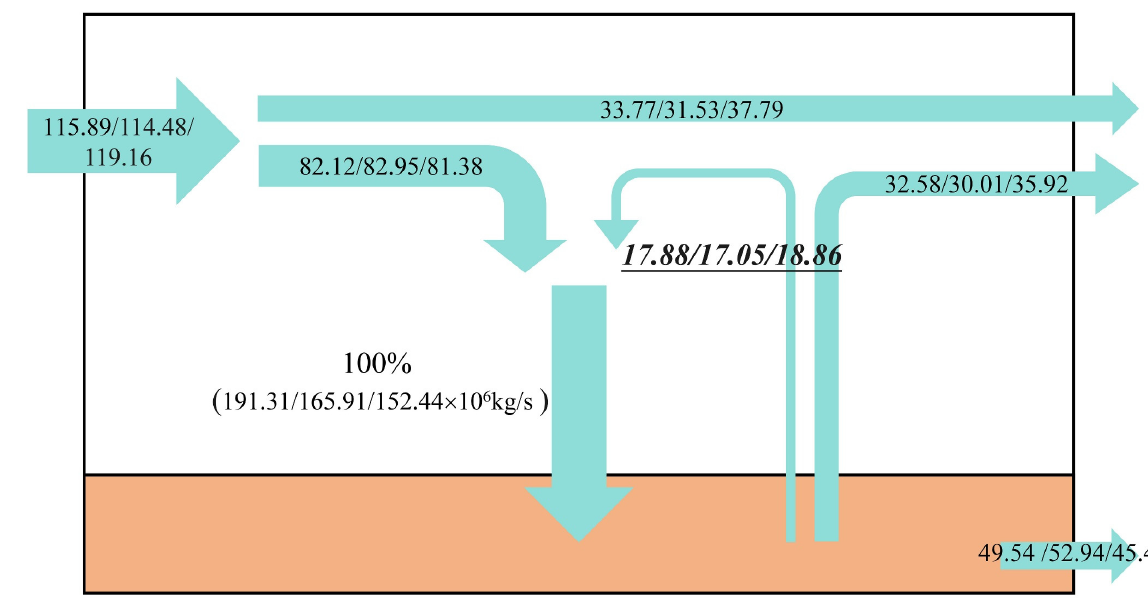
Figure 6. The contribution rate of local and external WVT on the TP to precipitation: for the three values of each atmospheric water cycle element, from left to right, they, respectively, represent the mean climatic value and the average value in strong and weak years.